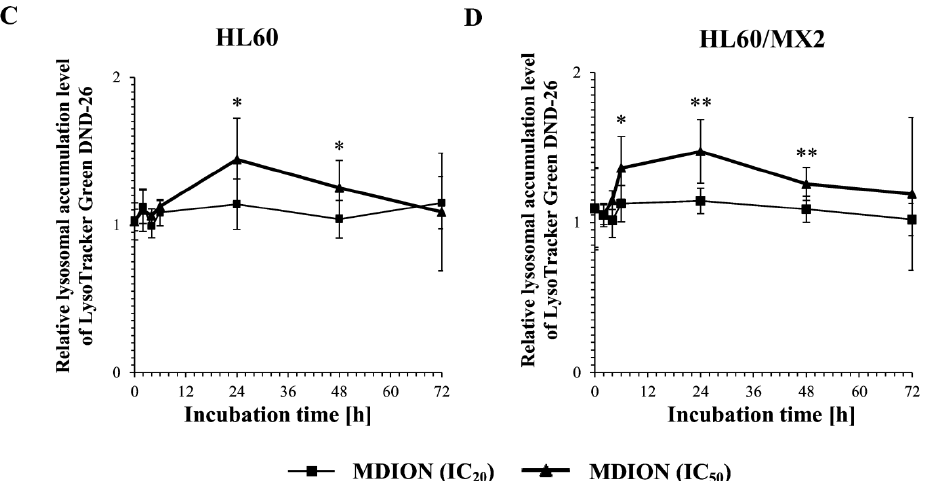
Figure 11. The effect of MDION on lysosomal integrity in sensitive HL60 ( A , C ) and resistant HL60/MX2 ( B , D ) leukaemia cells. The cells were incubated at 37 °C with MDION used at IC 20 (15.0 µM for HL60 cells and 17.0 µM for HL60/MX2 cells) or at IC 50 (80.5 µM for HL60 cells and 95.5 µM for HL60/MX2 cells), respectively, up to 72 h. The lysosomal integrity of the cells was examined with the use of flow cytometry by measuring the level of LysoTracker Green DND-26, a specific fluorescent lysosomal probe. The green fluorescence (FL-1 channel) of 5 × 10 3 events per sample was measured with the use of a laser beam at 530 ± 15 nm (λ ex = 488 nm). Presented histograms ( A , B ) are representative examples observed for control and treated cell samples (a, black — control cells; b, blue — cells treated with MDION at IC 20 ; and c, red — cells treated with MDION at IC 50 ). The experiment was repeated at least four times (made in triplicate) and the data are given as the mean ± SD values ( C , D ). The significance level of the differences ( Student’s t -test) between values found for cells treated with MDION at IC 20 (* p < 0.05) or IC 50 (* p < 0.05; ** p < 0.01), respectively, compared with values found for control cells.